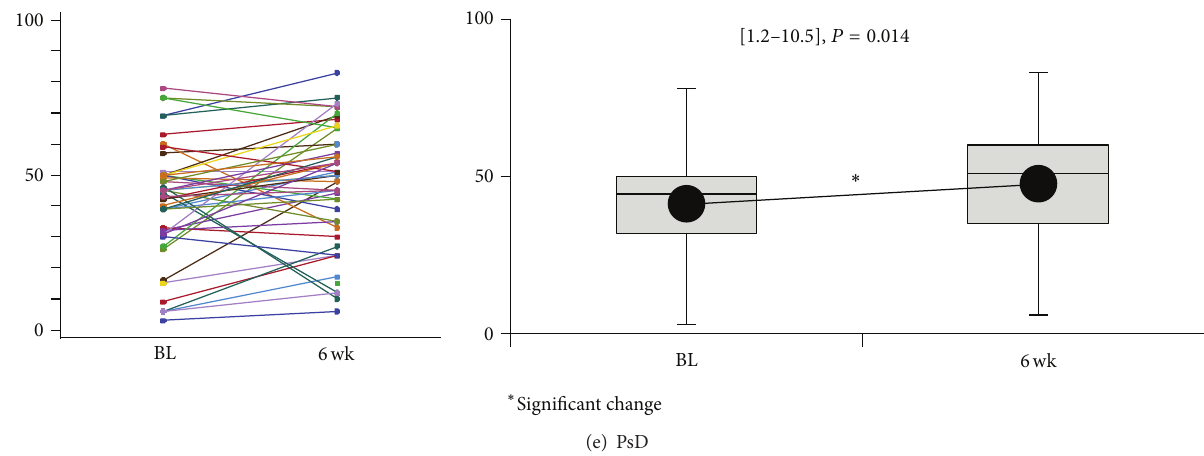
Figure 4: Score changes of the Japanese Orthopaedic Association Back Pain Evaluation Questionnaire (JOABPEQ) scores at baseline and at 6 weeks after pregabalin initiation. The average score at each time point is connected to indicate the tendency for change. Each of the items consists of raw data, followed by box and whisker plot. PaD: pain-related disorders, GaD: gait disturbance, LuD: lumbar spine dysfunction, SoD: social life disturbance, and PsD: psychological disorders. The scores for PaD, LuD, GaD, and PsD show a significant improvement after PGB treatment (identified by an asterisk), while that for SoD shows an improvement tendency with no significance.